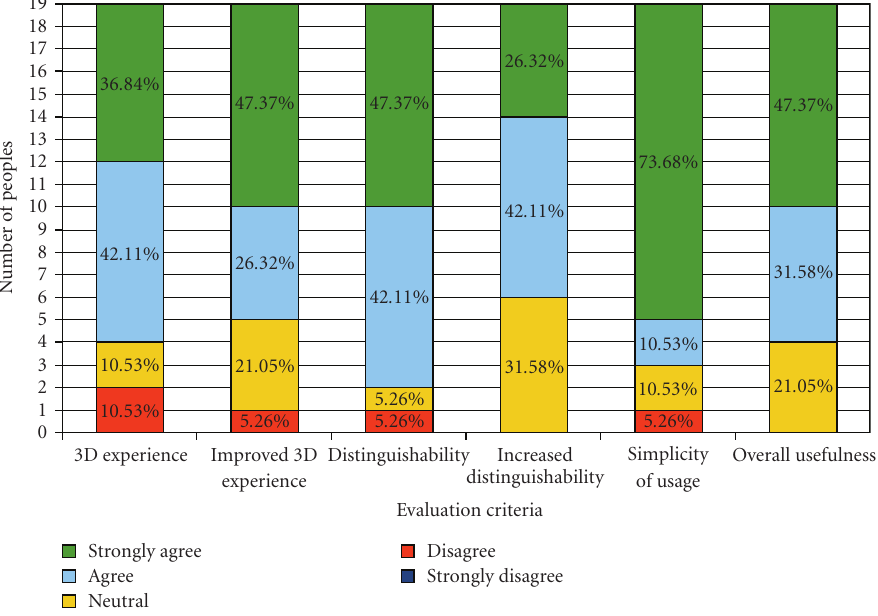
Figure 7: S3D-Cursor user evaluation